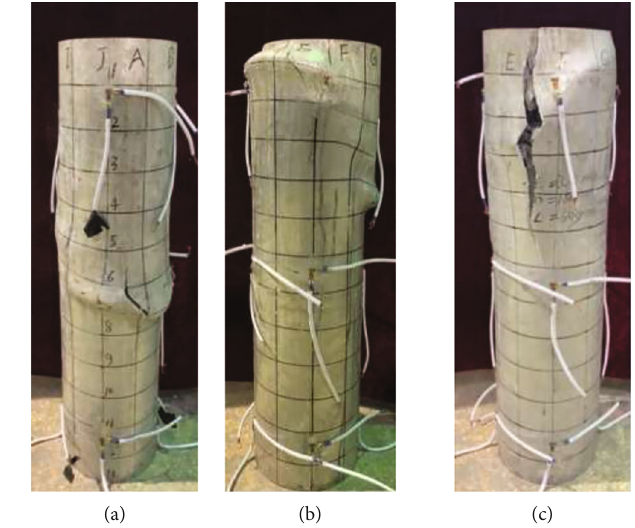
Figure 8: Failure pattern of aluminum alloy concrete